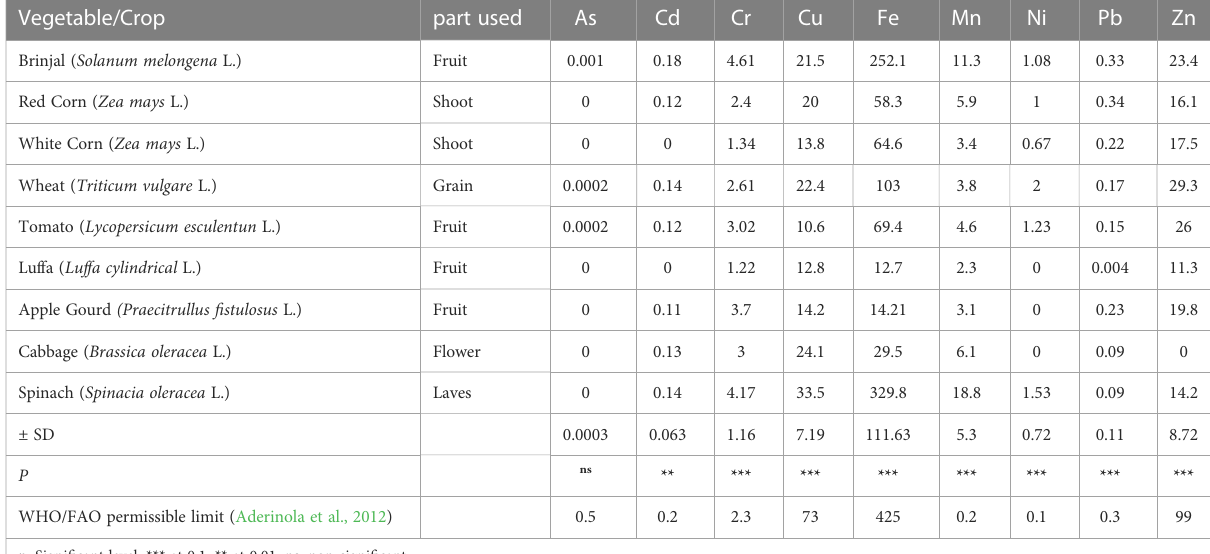
TABLE 2 Concentration of heavy metal content (mg kg -1 ) in vegetables/crop plants irrigated with wastewater. Vegetable/Crop